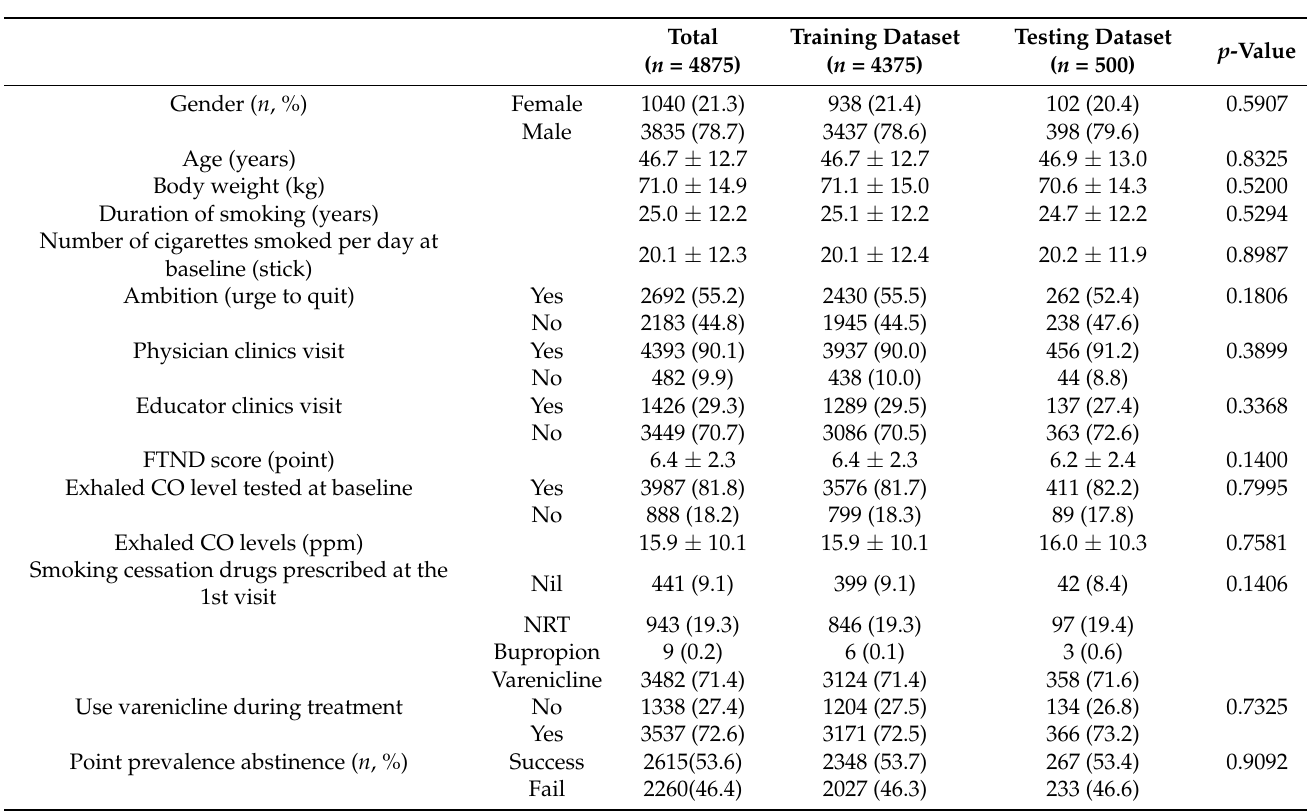
Table 1. Baseline characteristics of the training and testing dataset.